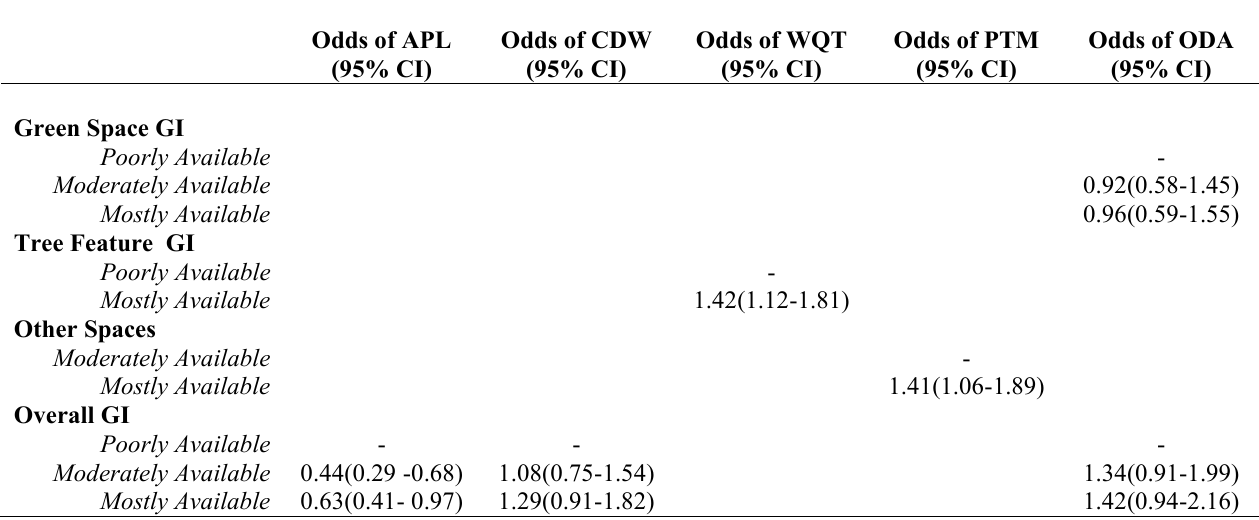
Table 5: Association of Green Infrastructure with Mitigation of Environmental Sustainability